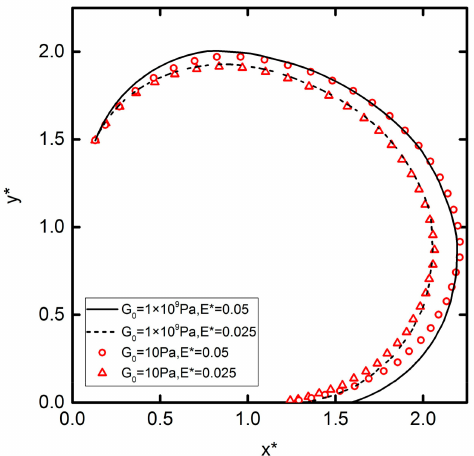
Figure 11. Trajectories of one particle initially located with θ = 85 ◦ and R * = 3. Lines and symbols represent G 0 = 1 × 10 9 Pa and G 0 = 10 Pa, respectively. Solid lines and circles represent E ∗ = 0.05. Dashed lines and triangles represent E ∗ =